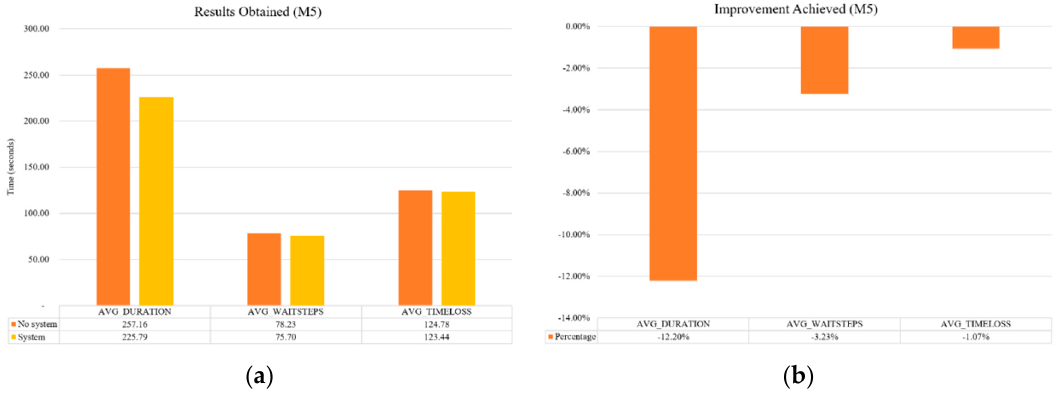
Figure 7. ( a ) Results obtained for M5 network, both without using the proposal (no system) and using it (system); ( b ) reductions obtained for different time measures.